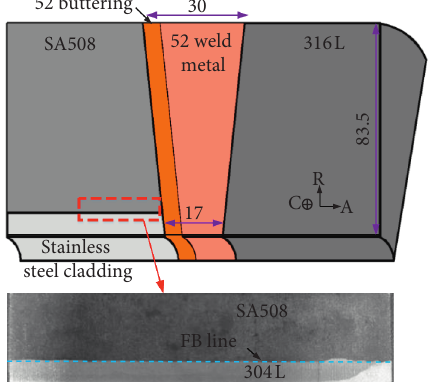
Figure 2: Stainless steel cladding layer specimen of welded joint of the pressure vessel ( C , circumferential; R , radial direction; and A , axial